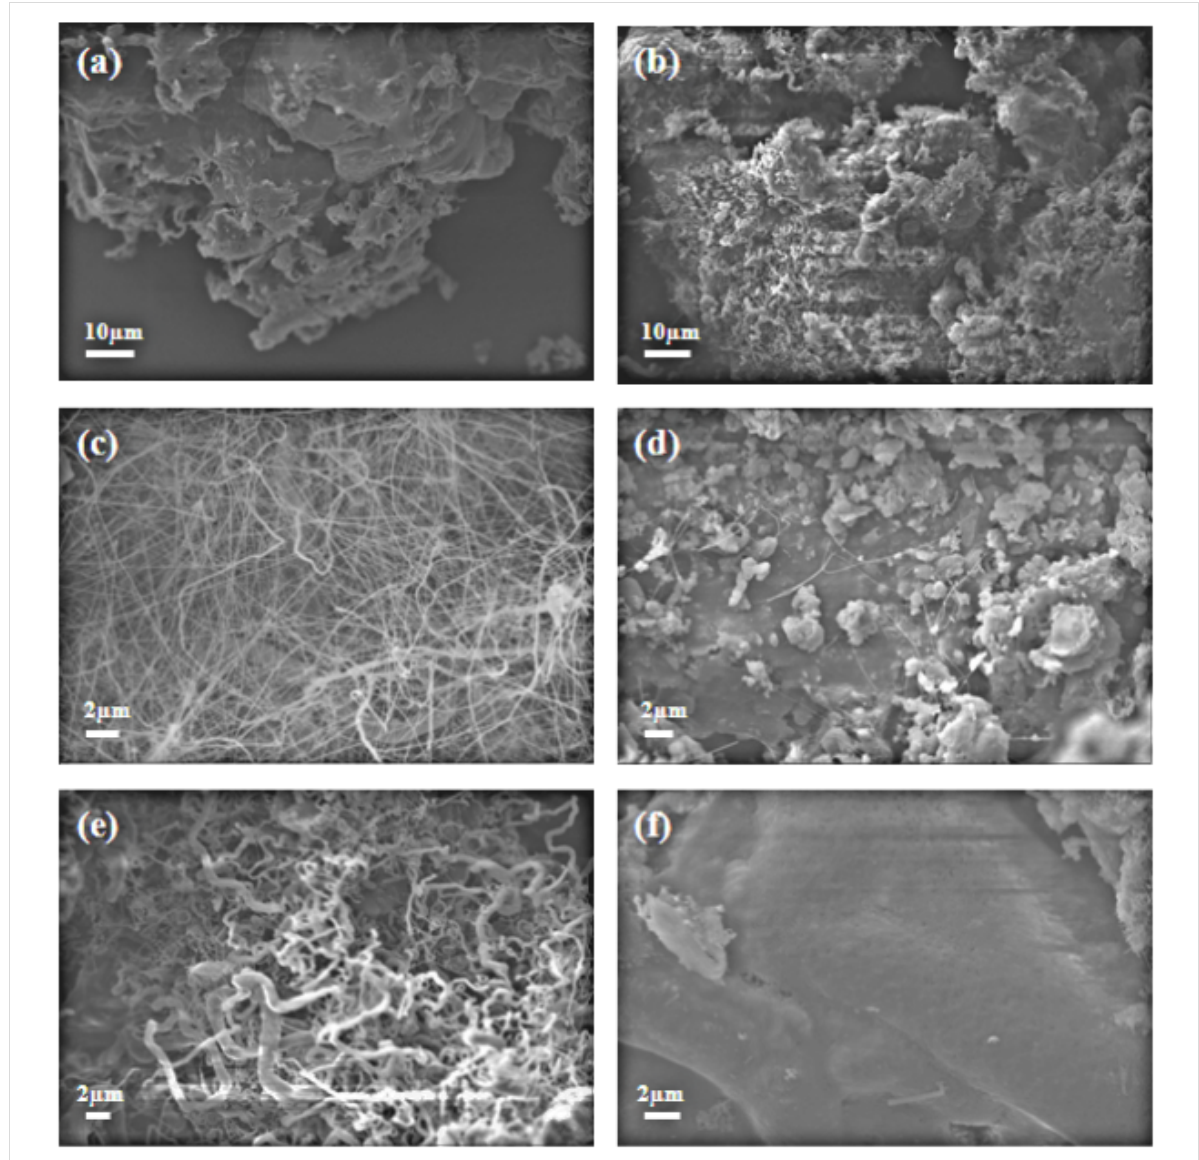
Figure 2: SEM images of the reaction mixtures with increasing reaction times (a–c) and colemanite/catalyst ratios (w/w) (d–f). With a ratio of 12:1 at (a) 30 min, and (b) 60 min. At 120 min with a ratio of (c) 12:1 (d) 32:1 and (e) 8:1. (f) Boat surface after removal of BNNTs, at 120 min and with a ratio of